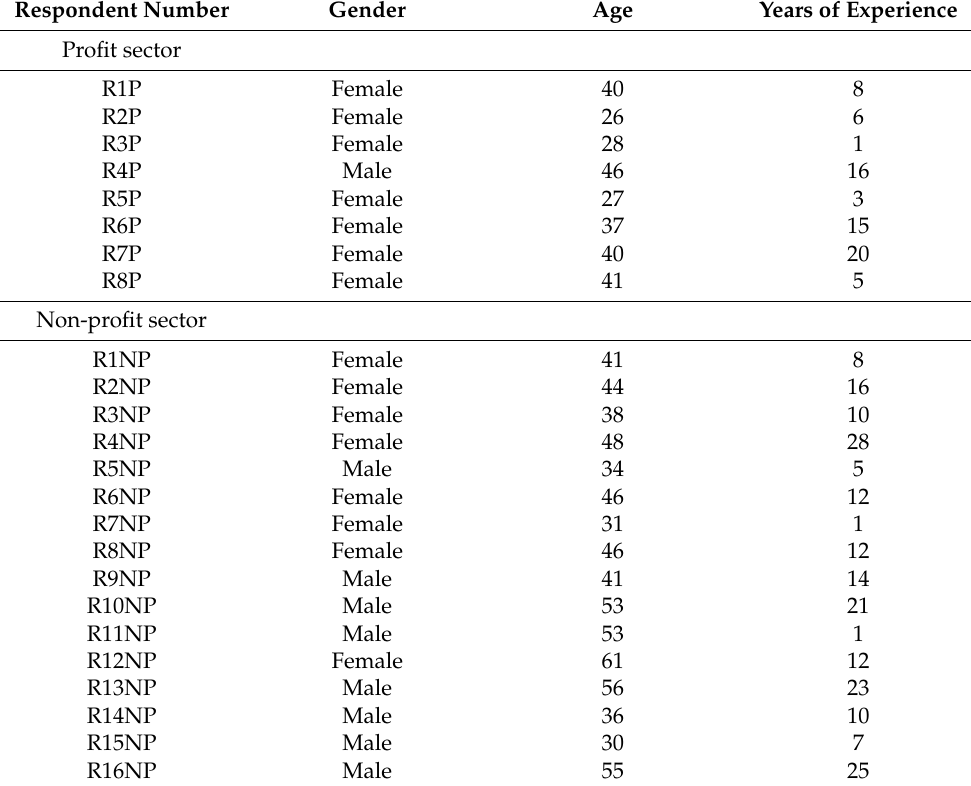
Table 1. Overview of the respondents and their characteristics. Respondent